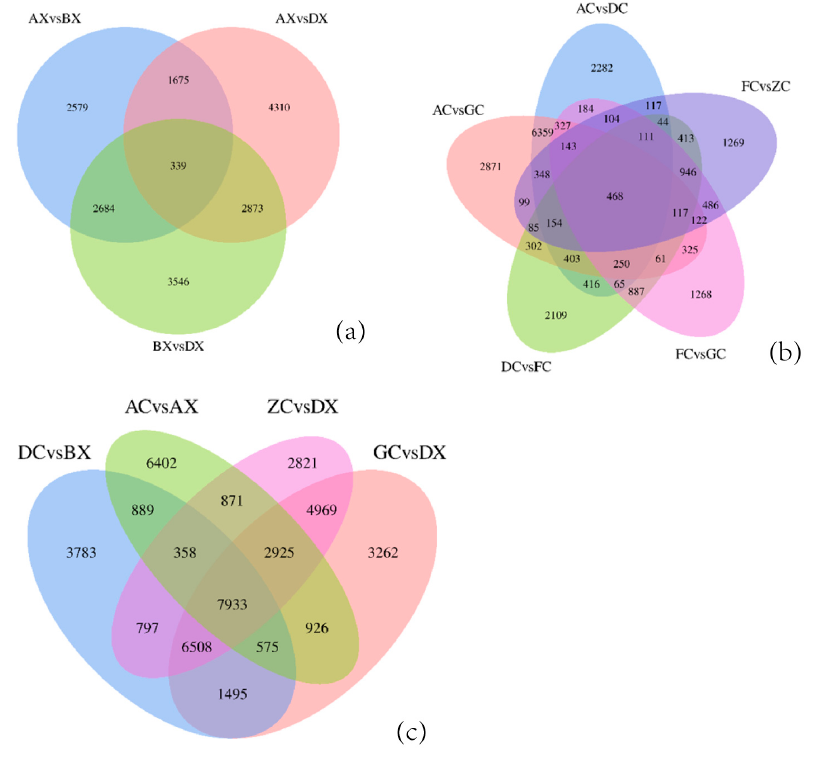
Figure 5. Venn diagram of differentially expressed genes in different gonadal development stages of Macrobrachium rosenbergii . ( a ): three pairwise comparisons of the testes; ( b ): the top 5 DEG pairwise comparisons of ovaries; ( c ) the top 4 DEG pairwise comparisons between testes and ovaries. AC—Stage Ⅰ ovary; DC—Stage III ovary; FC—Stage VI ovary; GC—Stage VII ovary; ZC— Stage VIII ovary; AX—Stage Ⅰ testis; BX—Stage II testis; DX—Stage III testis.